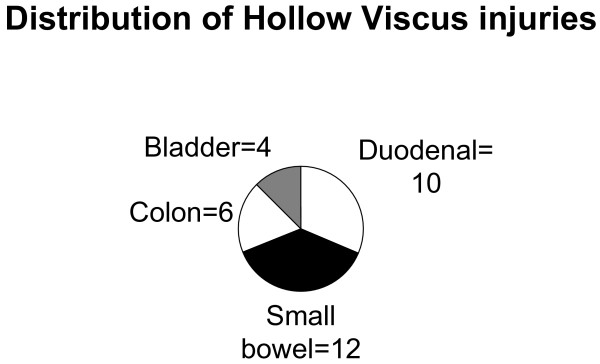
Distribution of HVI.